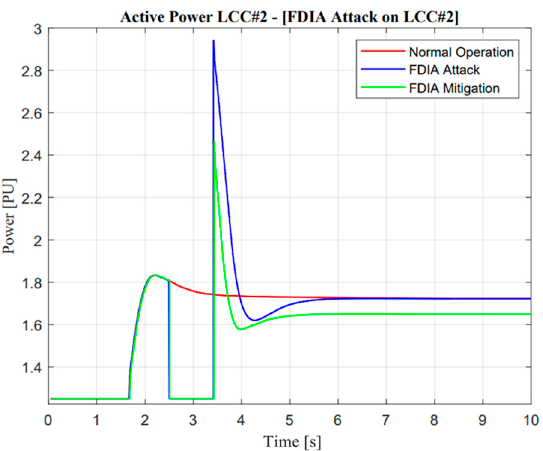
Figure 26. LCC active power response in the false data injection attack operation.